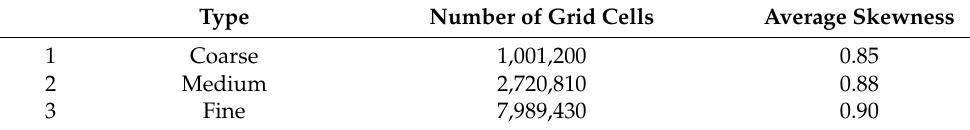
Table 1. Grid mesh parameters.